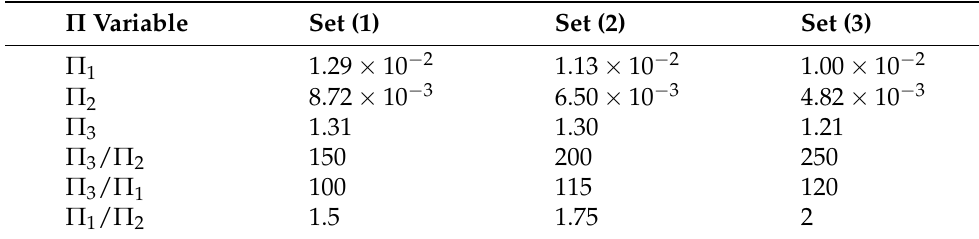
Table 1. Fixed Π Variables of Dimensional